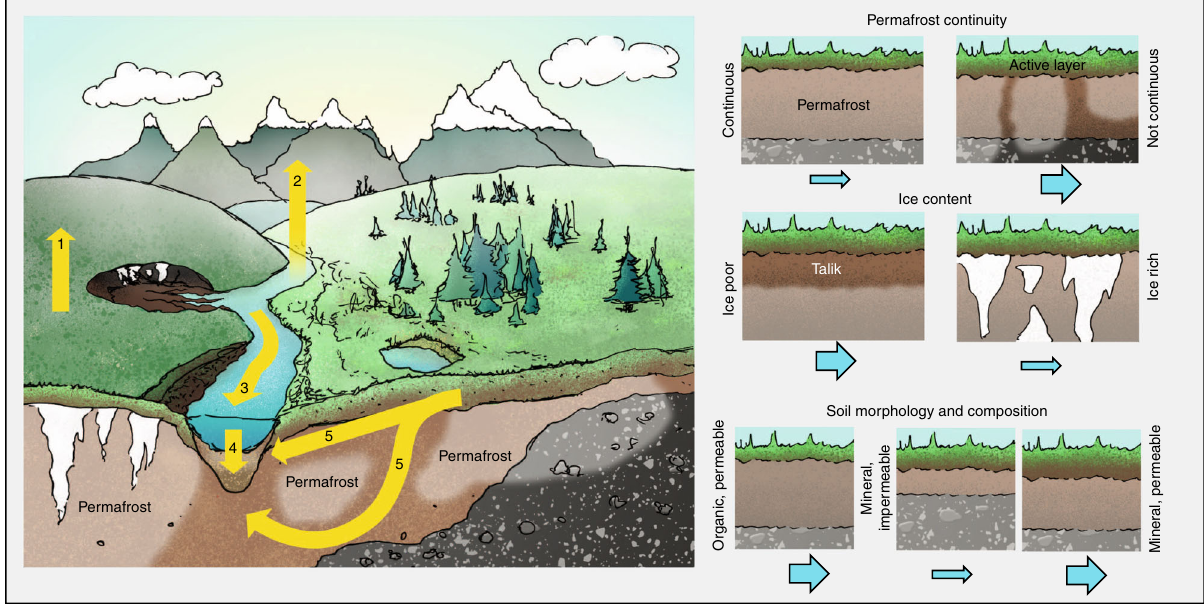
Fig. 1 Landscape heterogeneity across the frozen north. The left panel illustrates a tundra plateau underlain with ice-rich permafrost that is vulnerable to thermokarst, versus a forested environment underlain with discontinuous ice-poor permafrost that is vulnerable to active layer deepening and enhanced subsurface connectivity with permafrost thaw. These contrasts in permafrost continuity and ice content, as well as the illustrated differences in soil composition and topography, generate a wide subsurface variability which controls the susceptibility, rate, and biogeochemical and hydrological consequences of thaw. Yellow arrows indicate fi ve carbon pathways affected by thaw in an integrated terrestrial – aquatic continuum, with (1) terrestrial emission of greenhouse gases, (2) emission from waterways, (3) movement through inland and coastal waters, (4) sedimentary burial, and (5) leaching into and movement through porewater as illustrated. Current research tends towards isolated investigations of terrestrial (1), hydrologic (2), or aquatic (3 – 5) pathways, with a focus on the direct emission from terrestrial permafrost, i.e. only one of the fi ve pathways illustrated here. The right schematics illustrate the contrasts in primary landscape factors with blue arrows indicating the relative subsurface hydrological permeability or potential for lateral aquatic C transport. Topography is a forcing factor that shapes all three of the landscape factors shown